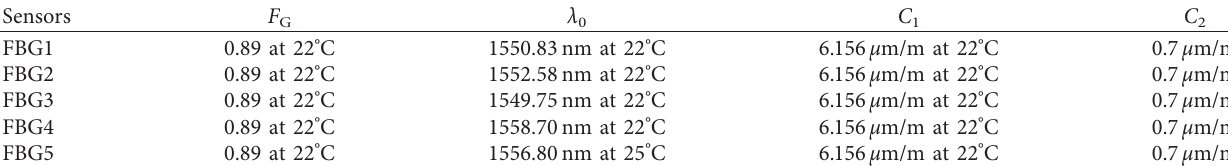
Table 1: Parameters of Osc3110.